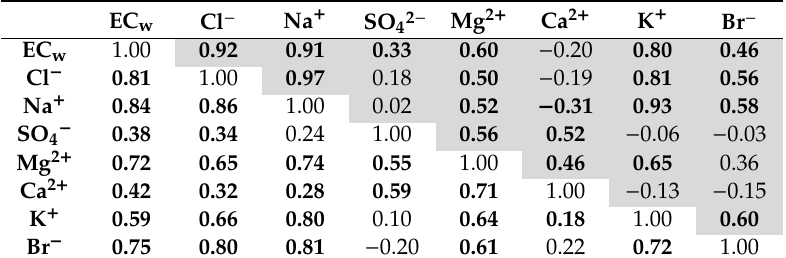
Table 4. Spearman’s correlations between electrical conductivity (EC) and ion concentrations in soil water (white cells) and groundwater (grey cells). Values range from − 1 to + 1 with larger absolute values indicating a stronger relationship. Bold values indicate significant correlations ( α = 0.05).